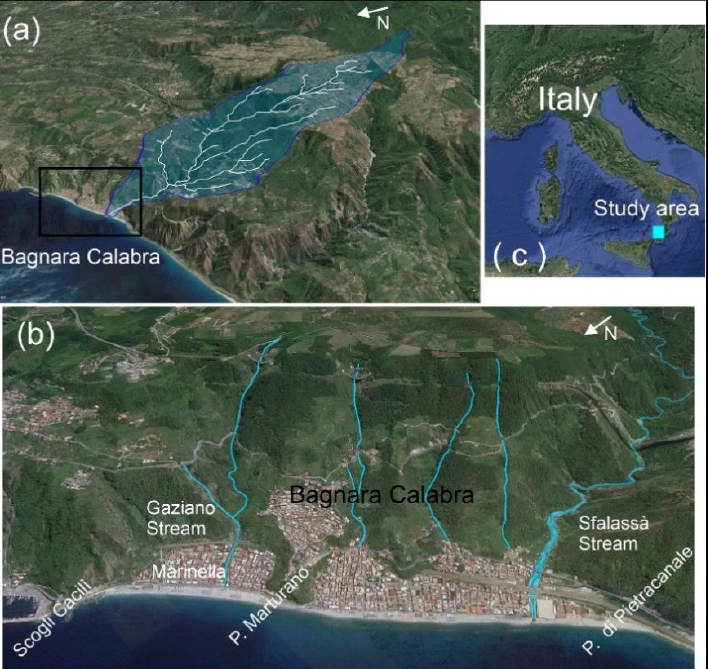
Figure 1. The images display the Sfalassà basin and river network overlaid on the 3D image of Google Earth ( a ), a detail of Bagnara Calabra coastal area ( b ) and the location of study area ( c ). Source: own elaboration draped over the Google Earth images.